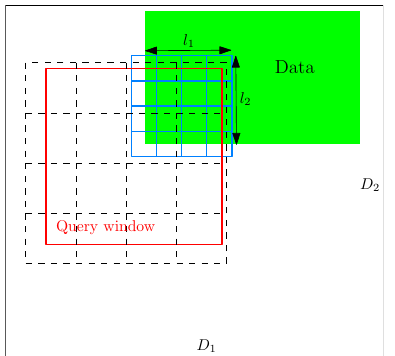
Figure 5. 2D window querying based on PlainSFC grid (dashed) and HistSFC grid (blue), T = 16